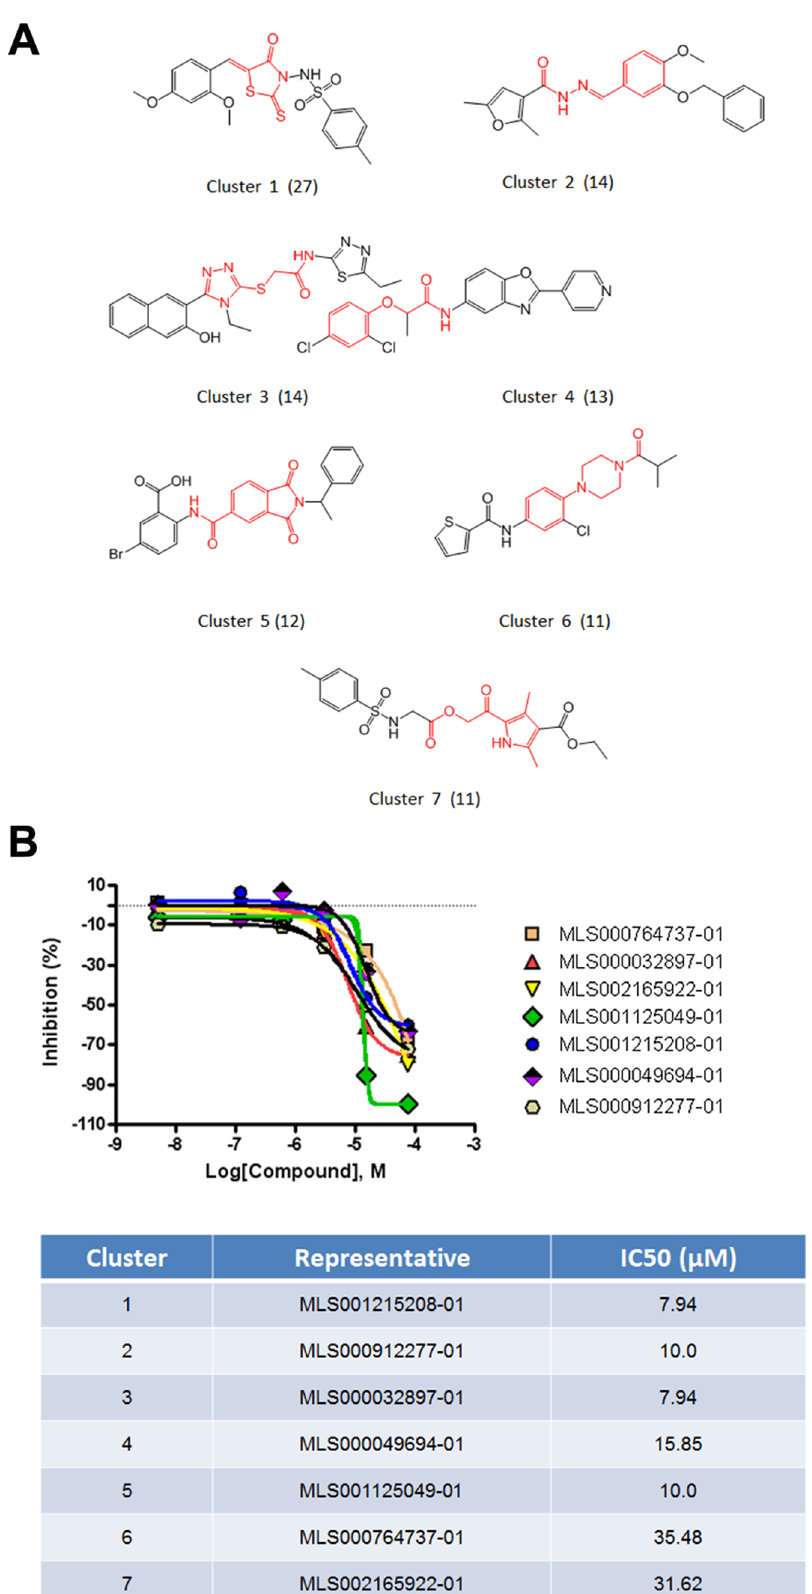
Figure 3. Clustering Analysis. Active compounds were clustered based on structural similarity to identify common chemotypes using LeadScope (Leadscope Hosted Client, Leadscope Inc., Columbus, OH). The results show a diversity of structural clusters, with 22 distinct clusters with more than 5